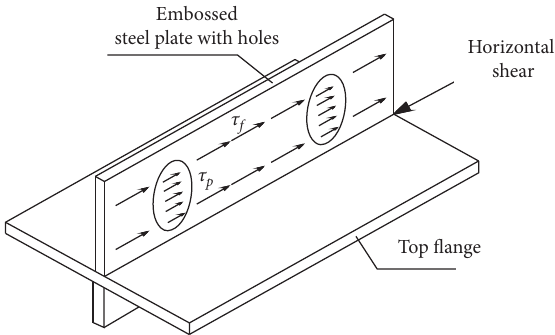
Figure 3: Mechanisms of shear resistance of the adhesive